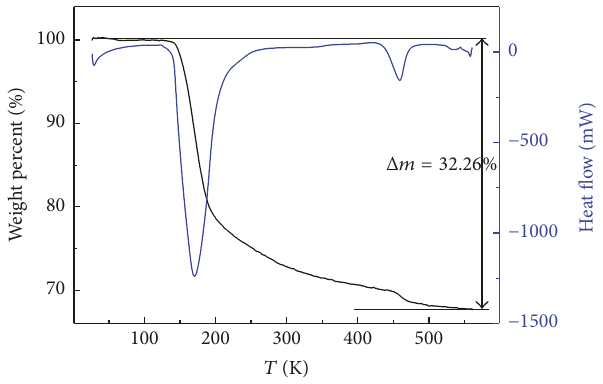
Figure 2: The TG curve of LiB 5 O 8 ⋅ 5H 2 O.